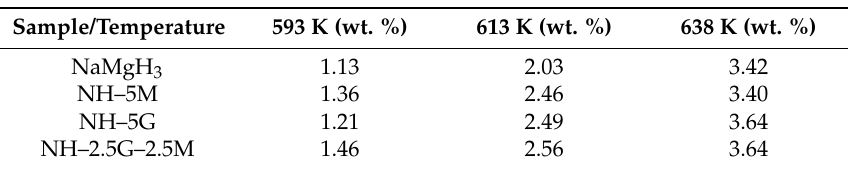
Table 2. The maximum amount of hydrogen desorbed from NaMgH 3 hydride and NH-CM composites at different temperatures.